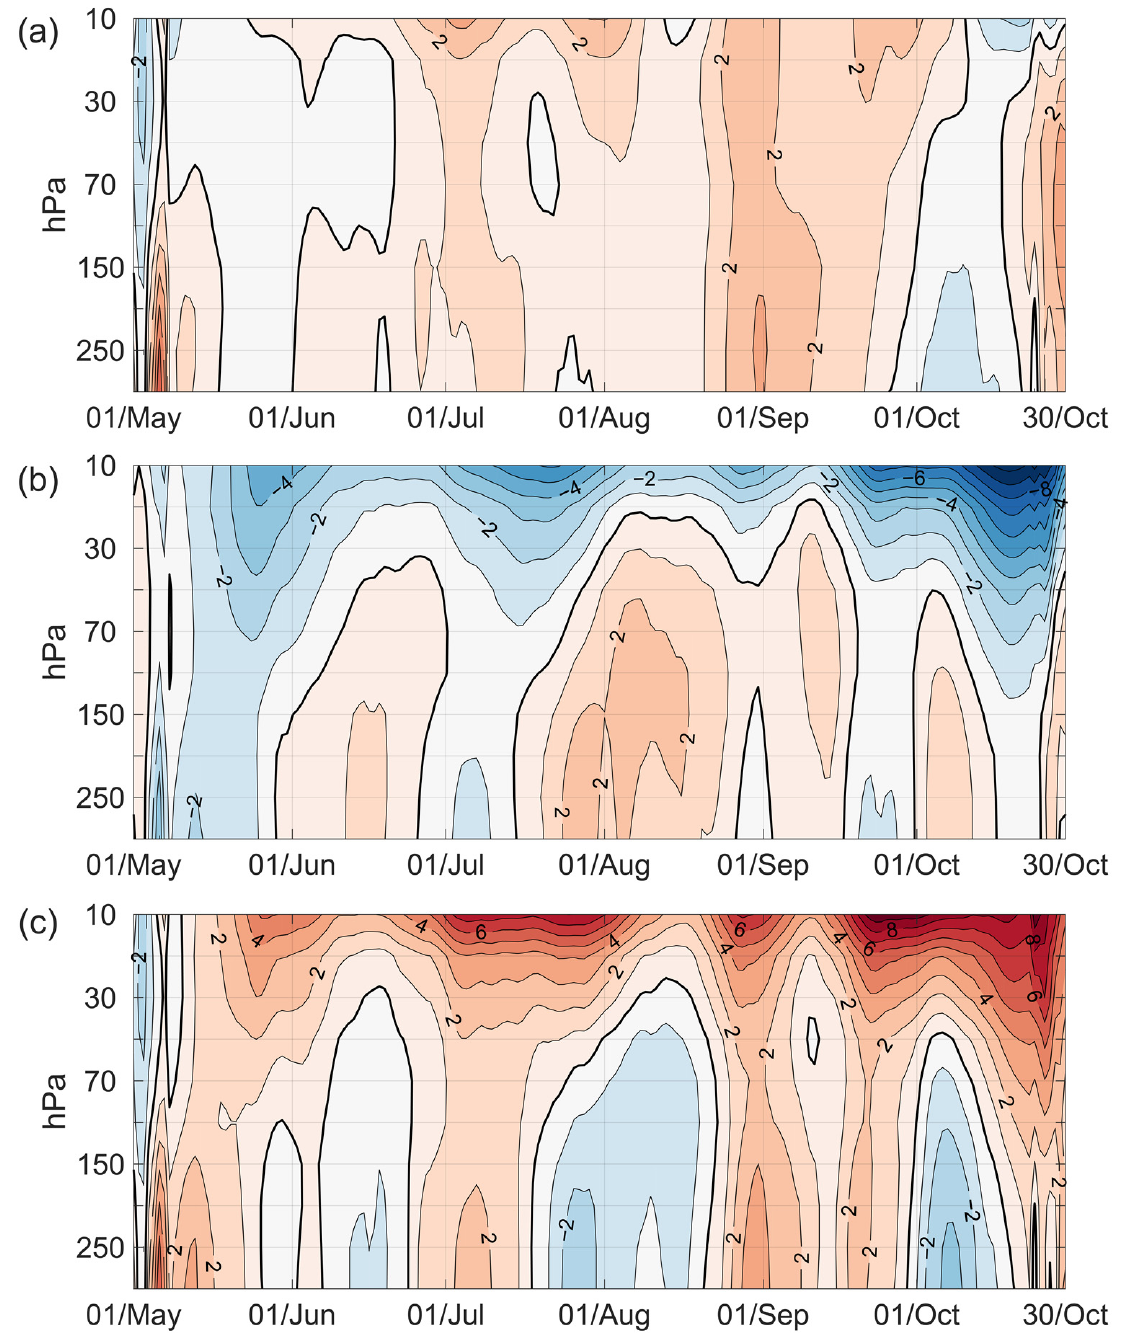
Figure 14. Composite vertical sections of daily anomalies in zonal mean wind at 60° S for ( a ) Eastern Pacific (EP) and ( b ) Central Pacific (CP) El Niño events and ( c ) difference between composites of EP and CP El Niño events. Values are smoothed with a 15-day running mean. Contour interval is 1 m/s. Black bold line indicates zero isoline.